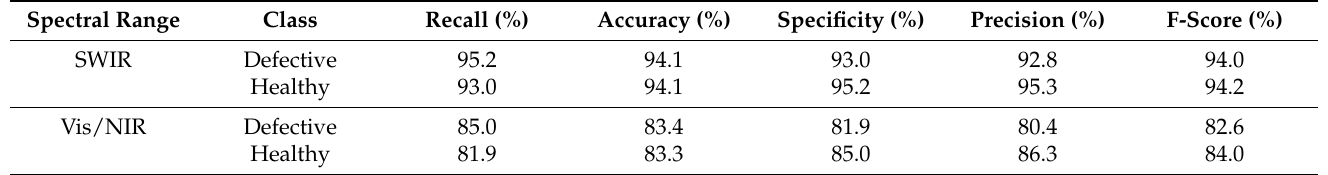
Table 3. Performance criteria of the MV classifier after 200 iterations in the two spectral ranges.